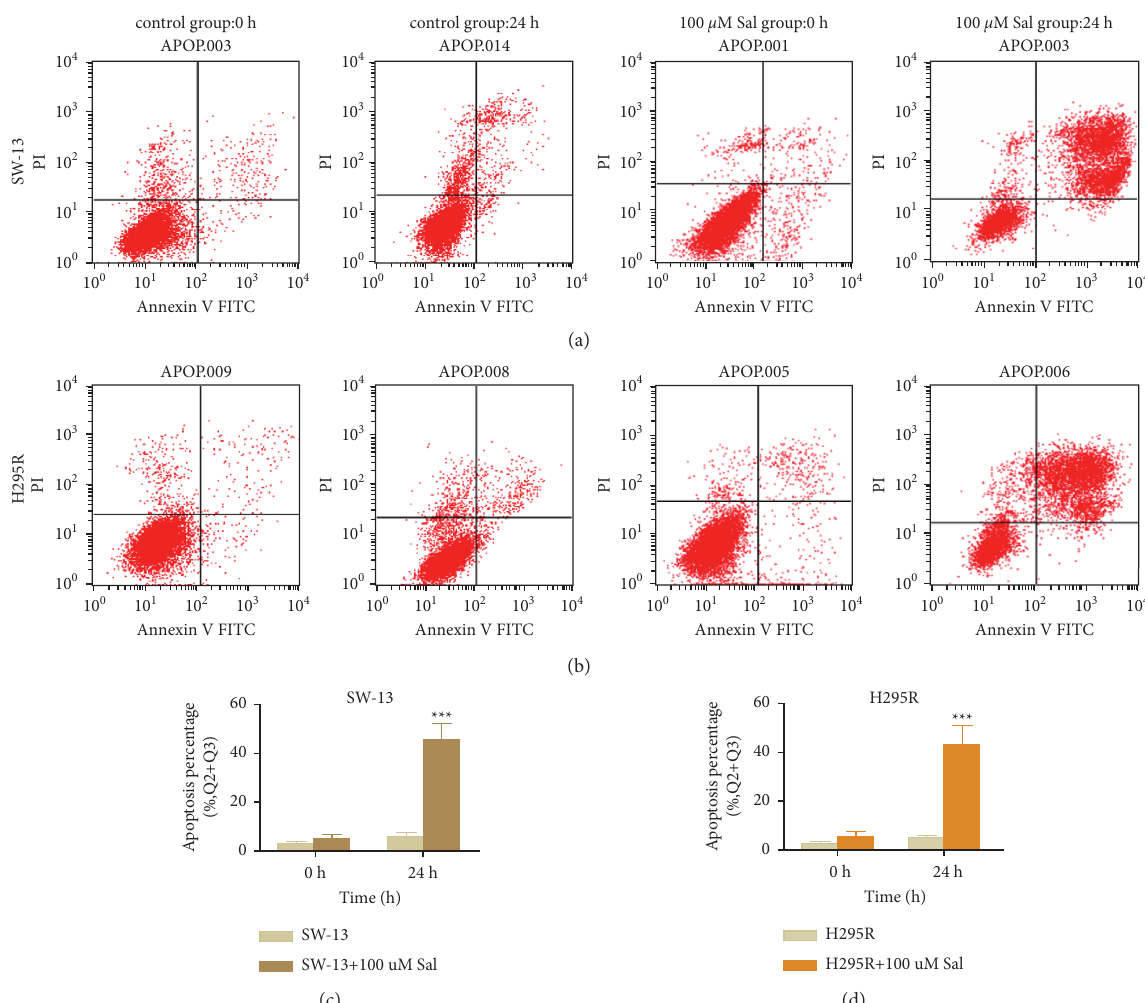
Figure 4: The effect of Sal in apoptosis in ACC cells. (a, b) The apoptosis rate of the ACC cells incubated in 0 μ m or 100 μ m of Sal for 0h and 24h. (c, d) Comparison of cell apoptosis rate of SW-13 and cells in A and B. The data represent the means ± SD ( n � 3). ∗∗∗ p < 0 . 001 compared with the control